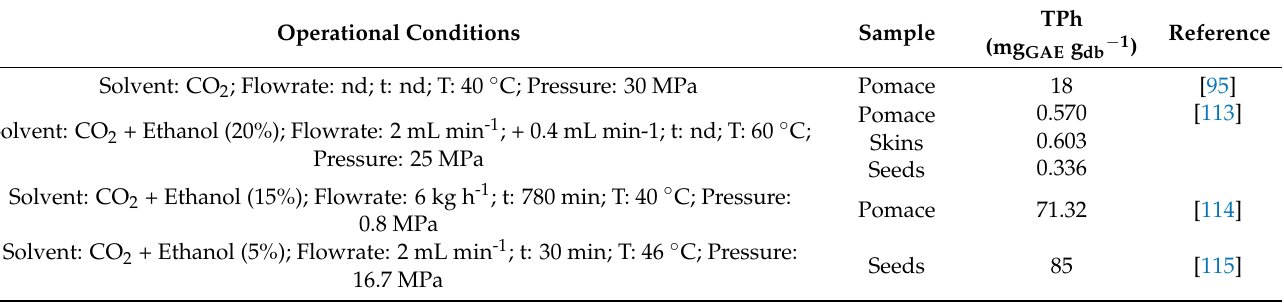
Table 10. Summary of supercritical fluid extraction for the recovery of phenolic compounds from winery